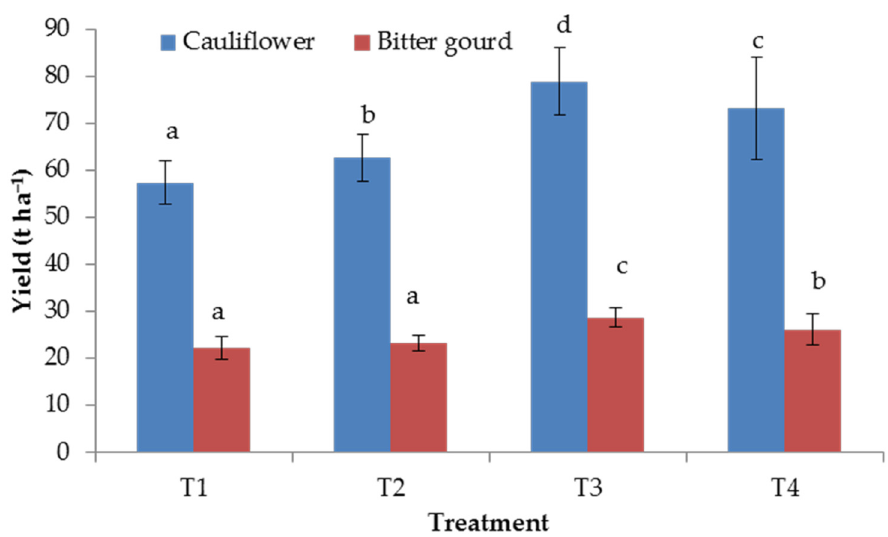
Figure 5. Impacts of different treatments on the yields of cauliflower and bitter gourd. Vertical bars for each column represent the standard deviation of the mean ( n = 3). Means of different treatments followed by the different lowercase letters (a–d) are significantly different ( p < 0.05) for the same